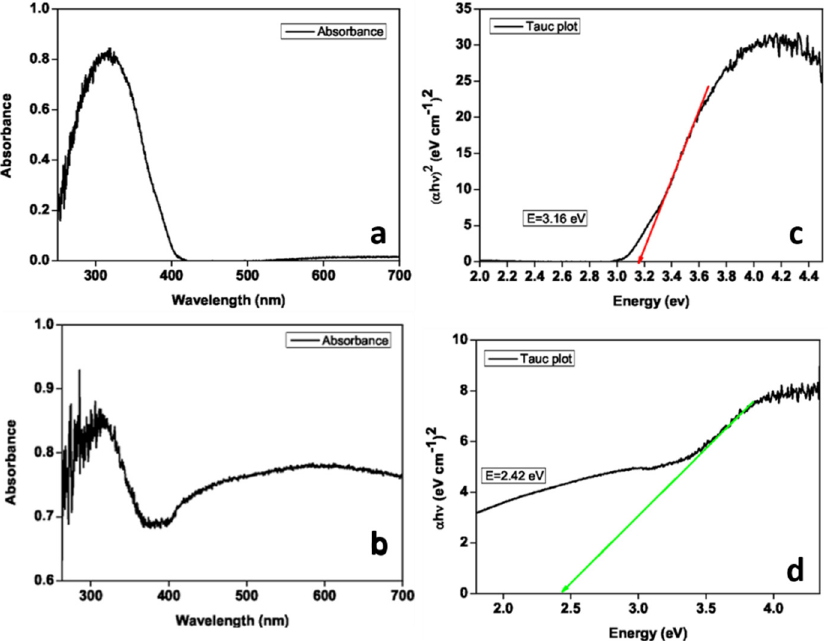
Figure 5. ( a , b ) UV-visible absorption spectra of TiO 2 and p-C/TiO 2 . ( c , d ) Tauc plot of TiO 2 and p- C/TiO 2 to find the bandgap, respectively.